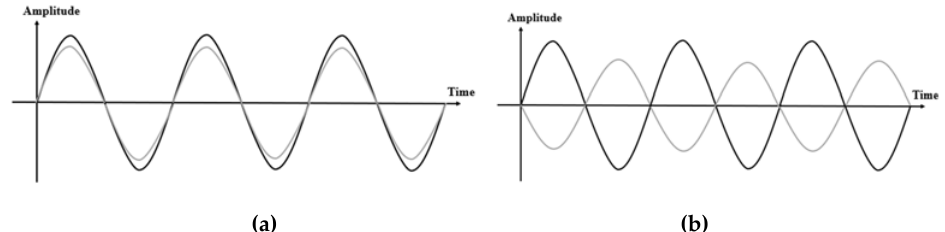
Figure 12. Signal amplitude with the human residing on the boundaries of Fresnel zones of odd and even numbers ( a ) odd zone ( b ) even zone.